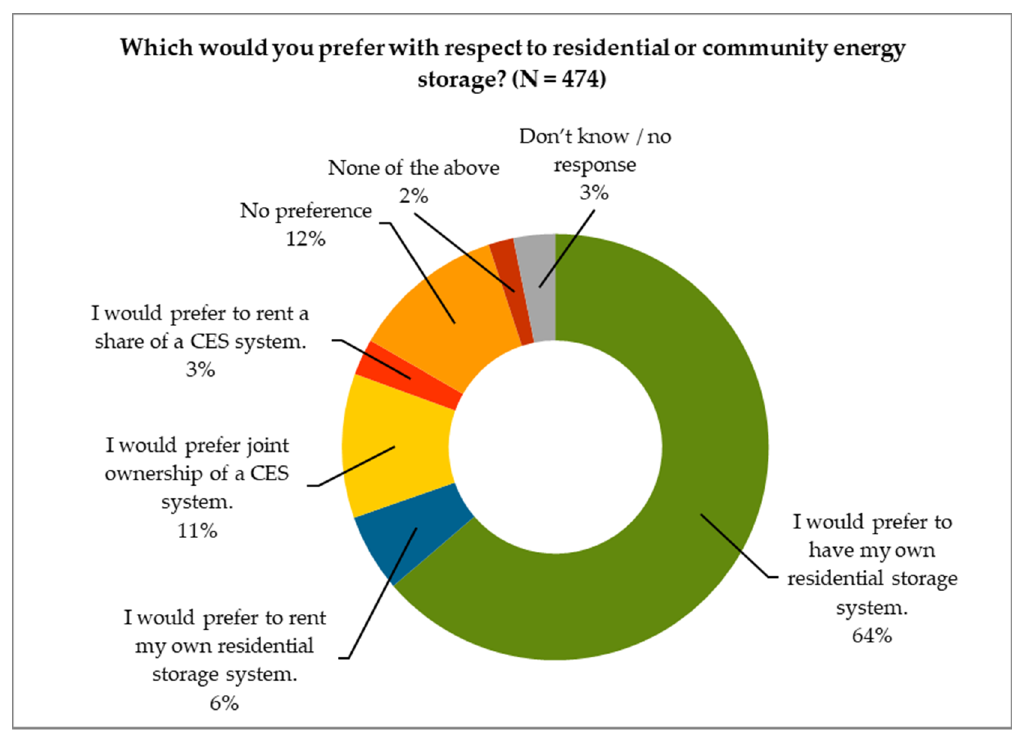
Figure 2. Preferred type of storage usage.